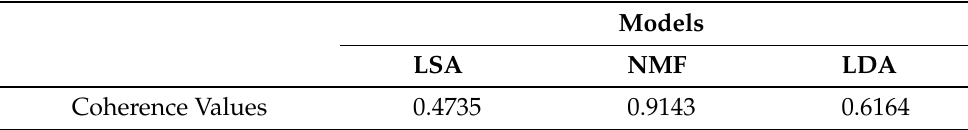
Table 1. Highest values of coherence obtained from the 3 models.